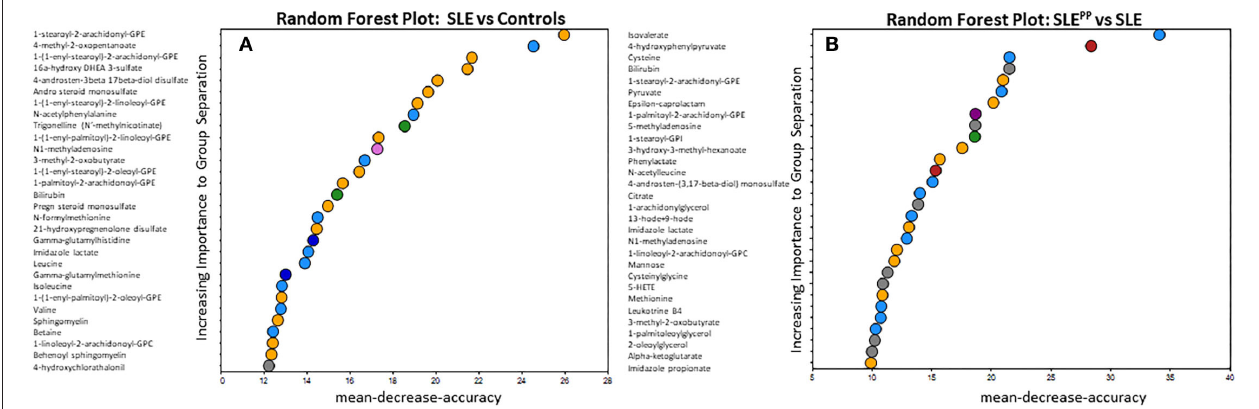
FIGURE 2 | Random Forest analysis of molecules with highest potential to discriminate between SLE vs. healthy and SLE PP vs. SLE shows that serum plasmalogens and branched chain amino acids have high importance to group separation. Baseline sera from SLE patients who did not develop atherosclerotic plaques, and SLE patients who later developed plaques (“SLE PP ”) were subjected to comprehensive metabolomics. Identified metabolites were analyzed using a Random Forest algorithm, plotted in (A,B) . The molecules that exhibited the greatest utility in accurately discriminating between SLE vs. healthy sera were 1-stearoyl-2-arachidonoyl-GPE, 4-methyl-2-oxopentanoate, 1-(1-enyl-stearoyl)-2-arachidonoyl-GPE, 16 alpha hydroxy DHEA 3-sulfate, and 4-androstene-3beta, 17beta-diol sulfate. In (B) , molecules that exhibited predictive potential in distinguishing between SLE PP and SLE are plotted. The five metabolites with the greatest importance to group separation and importance to accuracy of Random Forest predictions were isovalerate, 4-hydroxyphenylpyruvate, cysteine, bilirubin, and